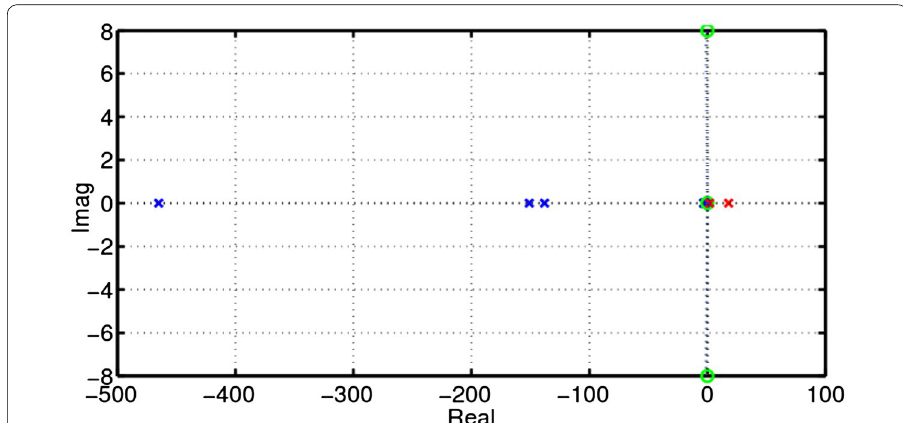
Fig. 11 Pole zero plot of eigenvalues for the composite load with ζ